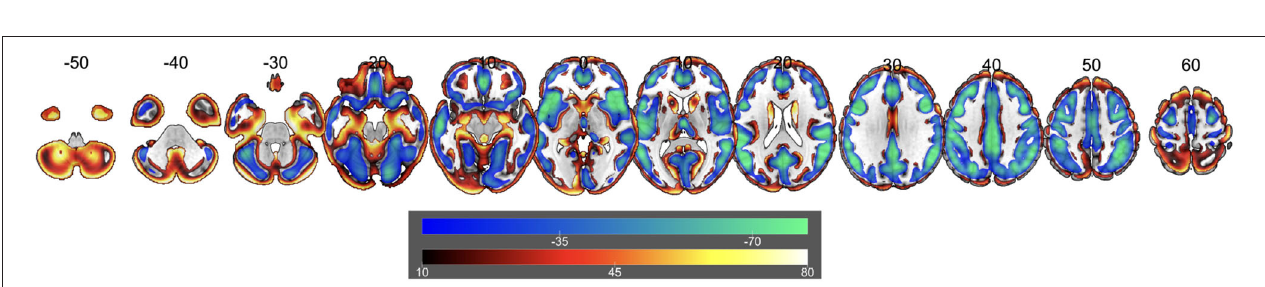
FIGURE 5 | Activation pattern for an OLS model trained on the gray matter Independent Components (ICs). Warms colors correspond to positive values and cold colors to negative values. The brain map has been produced by multiplying each entry of the activation pattern with the map corresponding to each IC, and then summing up all the maps. The choice of ρ does not affect the map in relative terms, it only affects its